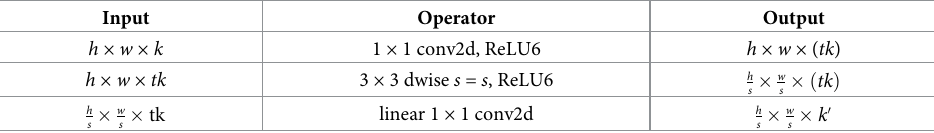
Table 1. Bottleneck residual block transforming from k to k 0 channels, with stride s , and expansion factor t .